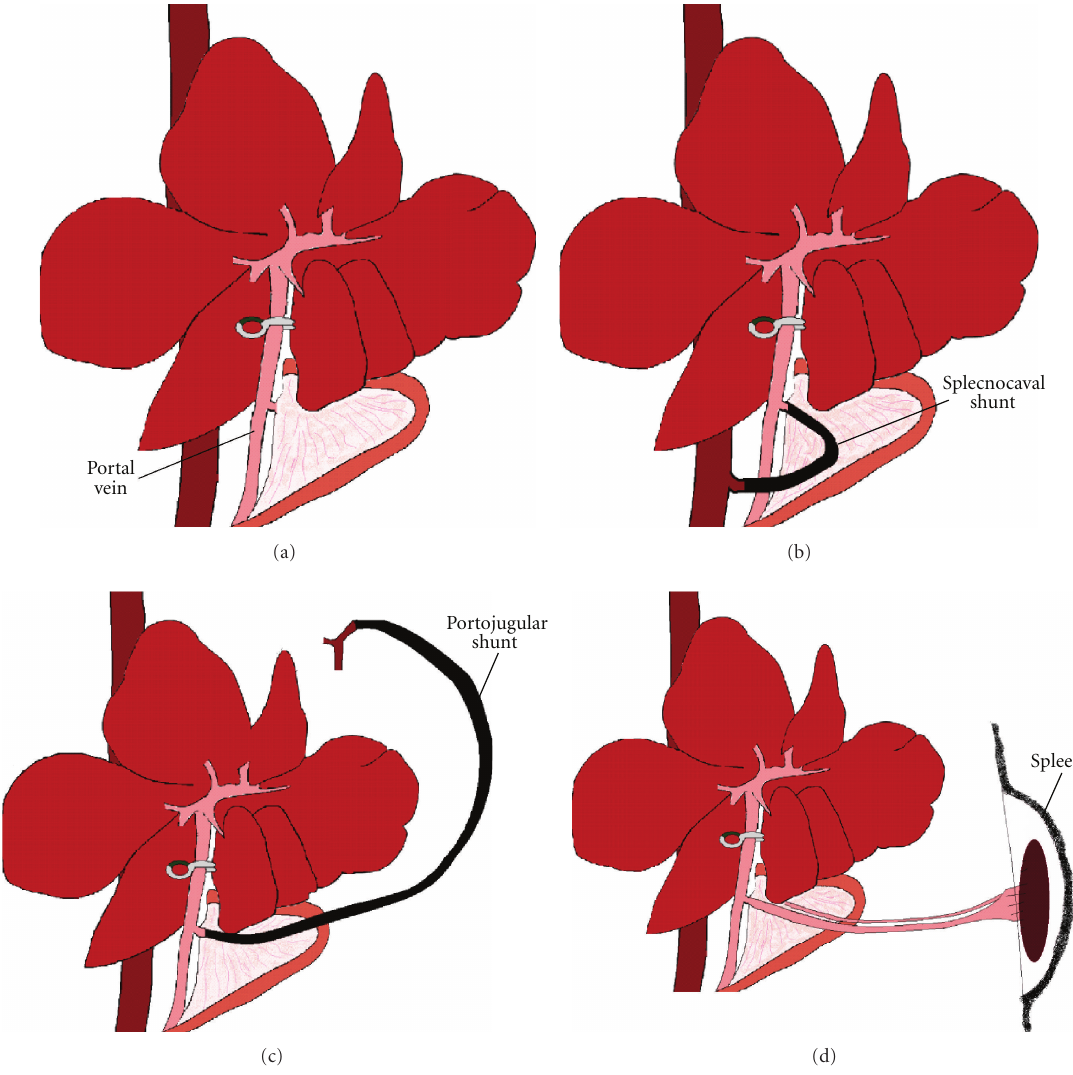
Figure 2: Models of global normothermic liver ischemia. (a) Pringle maneuver. (b) Splecnocaval shunt. (c) Portojugular shunt. (d) Spleen